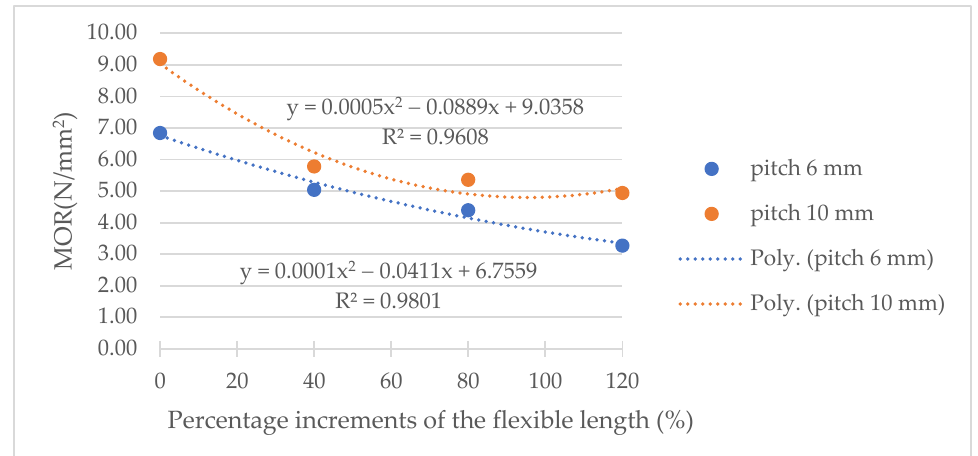
Figure 11. The variation in the MOE with an incremental increase in the flexibilization length, for two values of the model pitch.